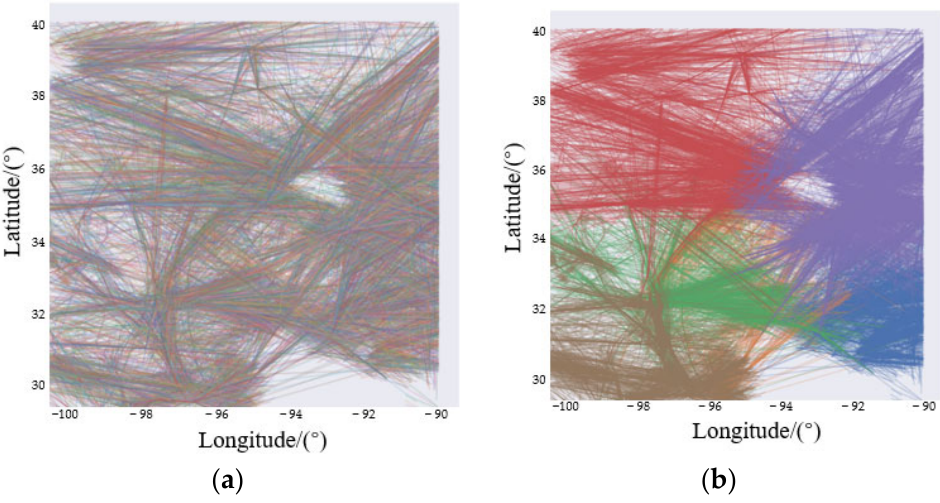
Figure 6. Trajectory clustering: ( a ) trajectory before clustering; ( b ) trajectory after clustering.